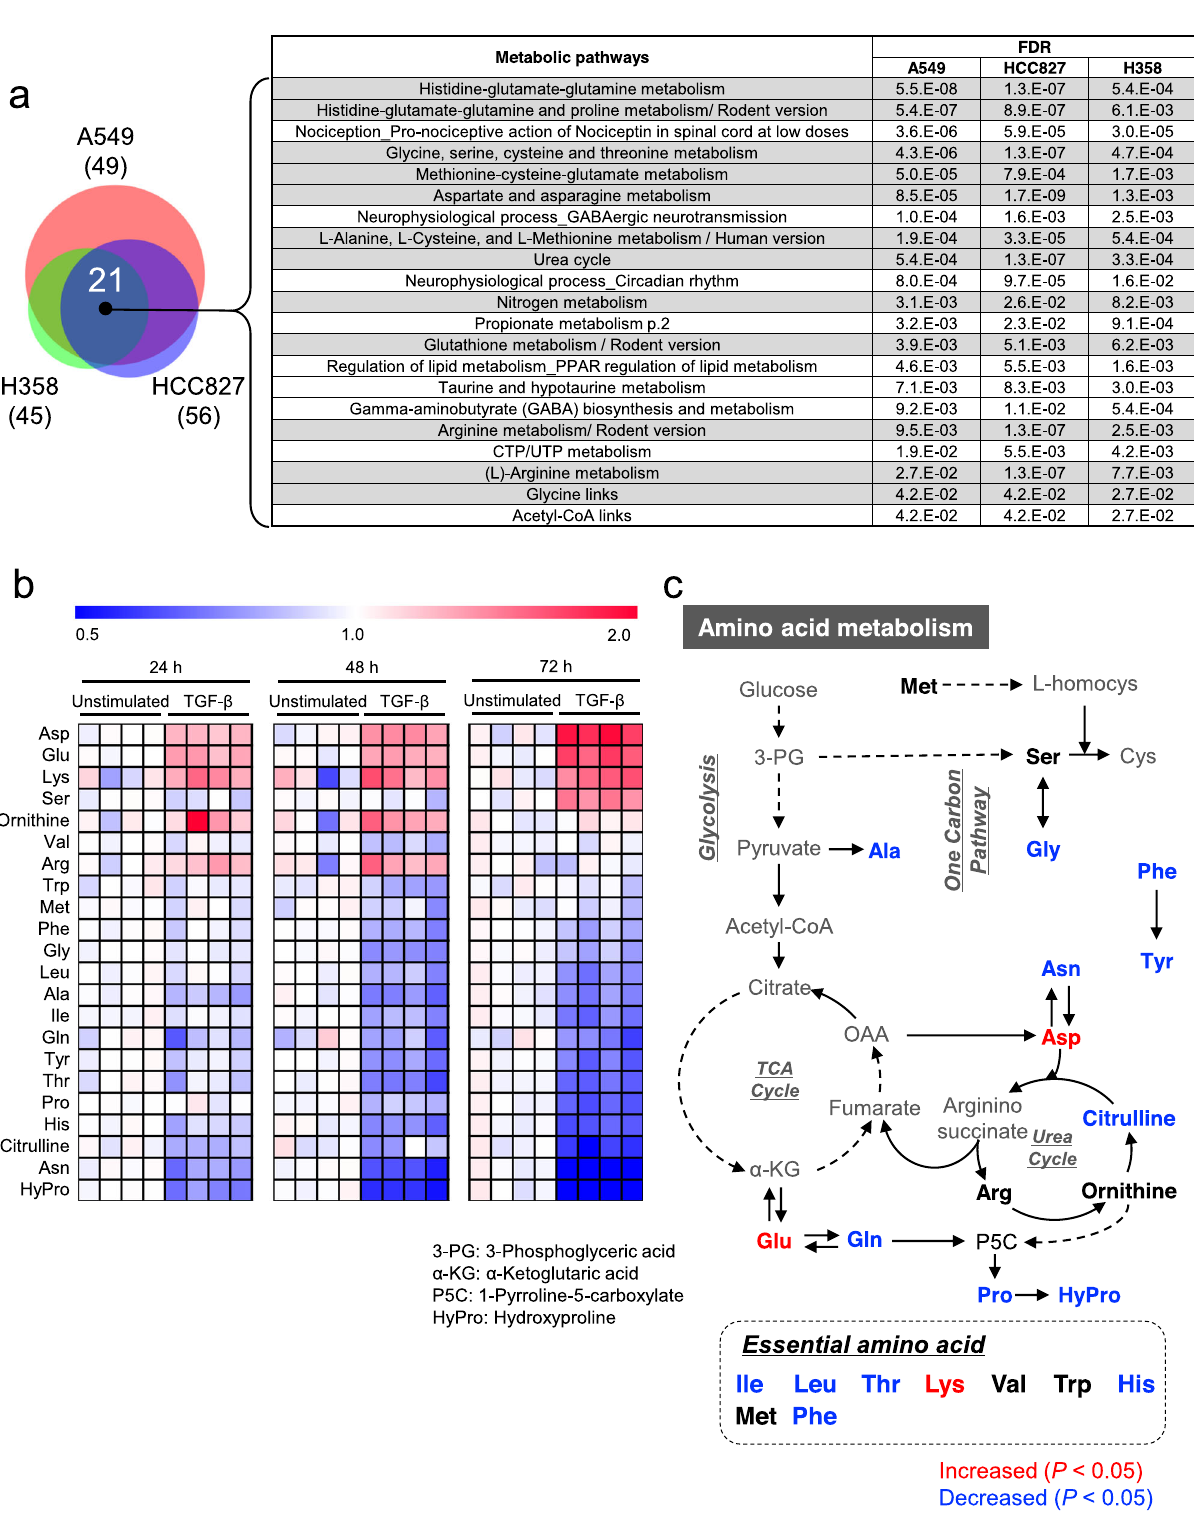
Fig. 1 Altered amino acid metabolism during TGF- β -induced epithelial – mesenchymal transition (EMT). a Venn diagram representing metabolic pathways that were signi fi cantly altered in TGF- β -stimulated A549, HCC827, or H358 cells compared to those in unstimulated cells. Cells were cultured in the presence of 2 ng/mL TGF- β for 2 – 5 weeks to induce EMT. Metabolite levels were detected by capillary electrophoresis time-of- fl ight mass spectrometry. Pathway signi fi cance was assessed using P values and false discovery rates (<0.05). The light gray-shaded rows in the table indicate the pathways of amino acid metabolism. b and c Alteration of amino acid metabolism in A549 cells during TGF- β -induced EMT. b Heat map showing the time- course of amino acid levels in A549 cells stimulated with or without 5 ng/mL TGF- β ( n = 4) for 24, 48, and 72 h. Metabolite levels in each sample were converted to a fold-change relative to average metabolite level of the paired non-stimulation. Red and blue indicate higher and lower levels, respectively, of metabolites in TGF- β -stimulated cells compared to those in the unstimulated cells (white). c The metabolites indicated by red or blue on the map for amino acid metabolism were signi fi cantly up- or down-regulated by TGF- β treatment for 72 h, respectively. COMMUNICATIONS BIOLOGY| (2021) 4:782 |https://doi.org/10.1038/s42003-021-02323-7|www.nature.com/commsbio